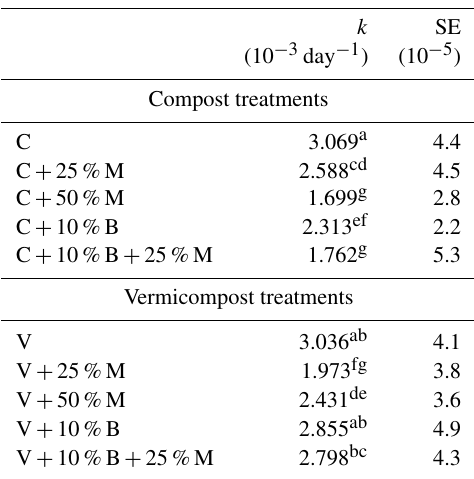
Table 2. Effect of the addition of clay and/or biochar on the rate constant k (day − 1 ) during composting and vermicomposting. Dif- ferent superscript letters indicate significant differences between treatments (Kruskal–Wallis test, p < 0.005). C: compost; V: ver- micompost; B: biochar; M: clay. Data with different small letters indicate significant differences between